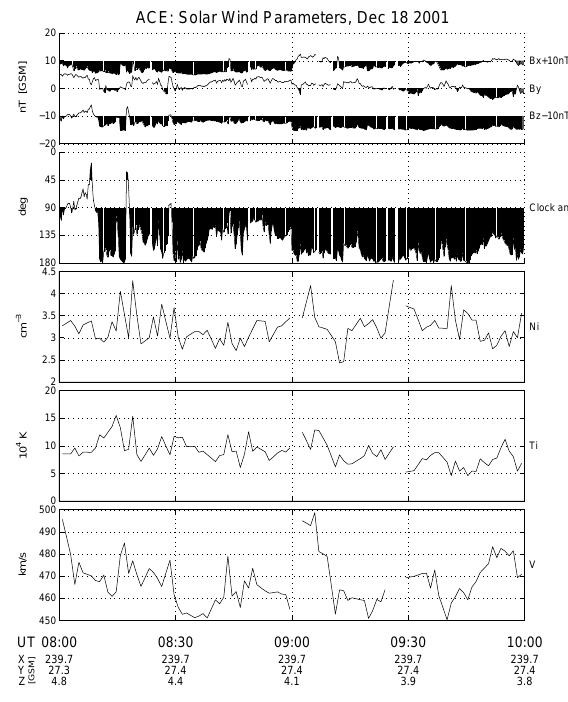
Fig. 1. Interplanetary magnetic field and solar wind parameters from the ACE spacecraft. The panels show from the top: the three components of the interplanetary magnetic field (negative values indicated with shading), the clock angle of the interplanetary mag- netic field ( > 90 ◦ or southward field indicated with shading), the solar wind ion density (Ni), the solar wind ion temperature (Ti), and the solar wind velocity